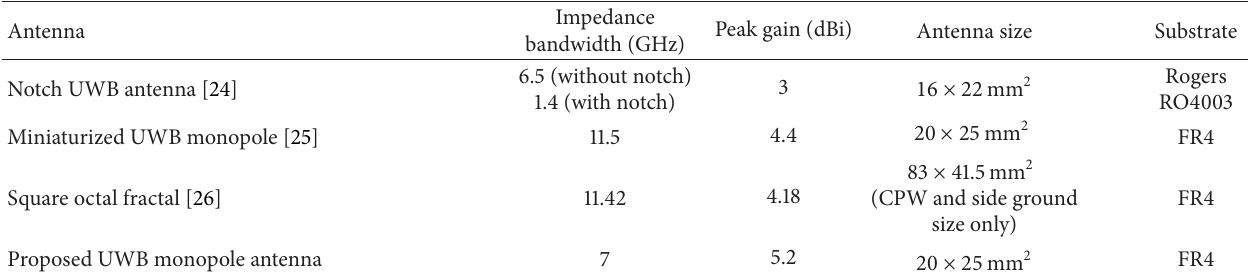
Table 3: Comparison with conventional antennas.